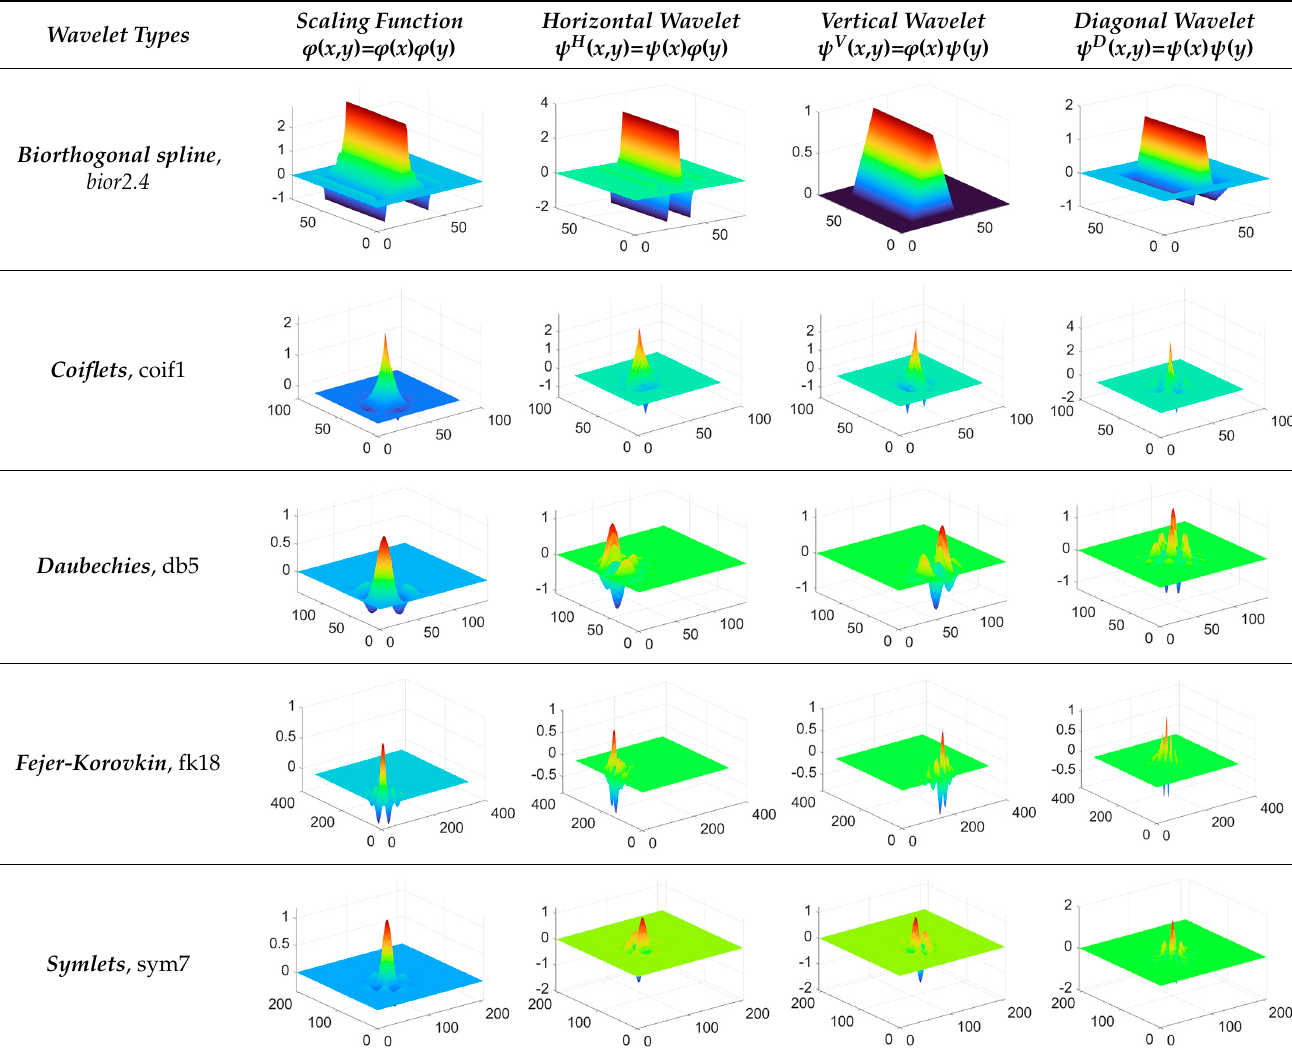
Table 1. Scaling and mother wavelet functions of wavelets that provide the best classification performance for each wavelet type used in the study.